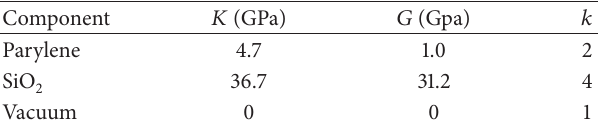
Table 2: Properties of the structural components for models of coated porous ultralow 𝑘 dielectrics.